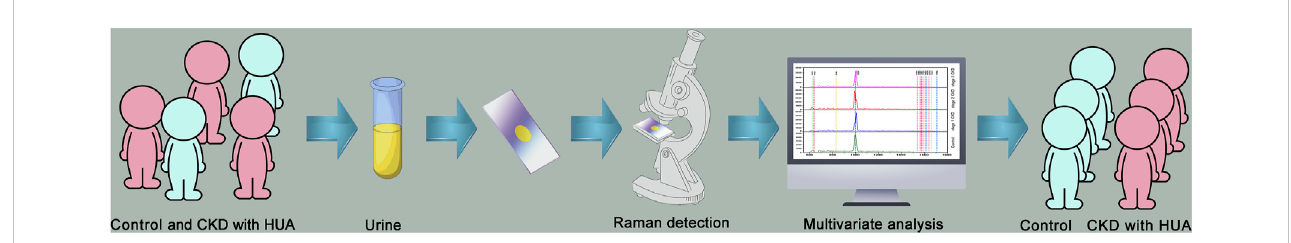
FIGURE 1 Schematic diagram for obtaining a Raman spectrum of urine: the spectrum for the subject under study was obtained by Raman spectroscopy. SIMCA 14.1 was used to analyze the data set through multivariate statistical analysis to distinguish patients with HUA and